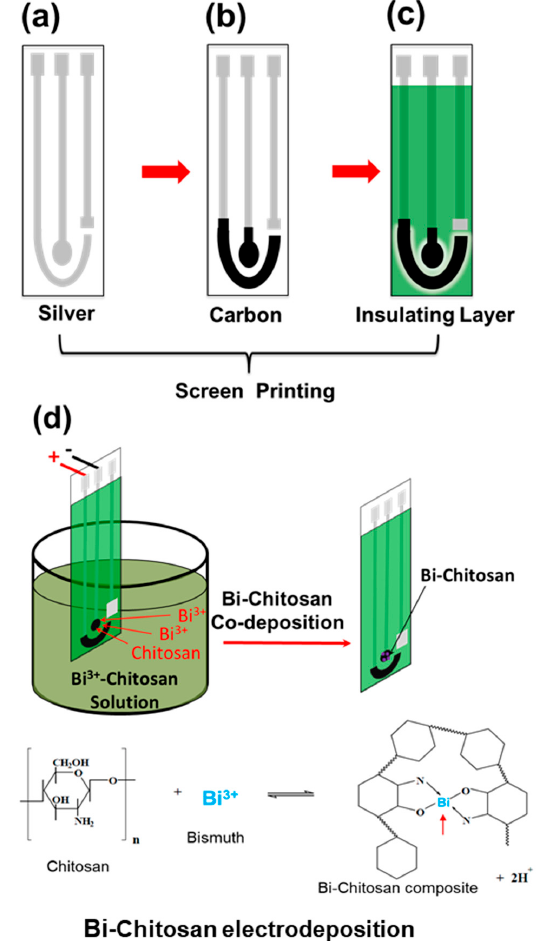
Figure 1. A schematic of the Bi-chitosan sensor fabrication process. ( a ) Silver layer, ( b ) carbon layer, ( c ) insulating layer fabricated by screen printing, and ( d ) electrochemical co-deposition of Bi-chitosan nanocomposite film.